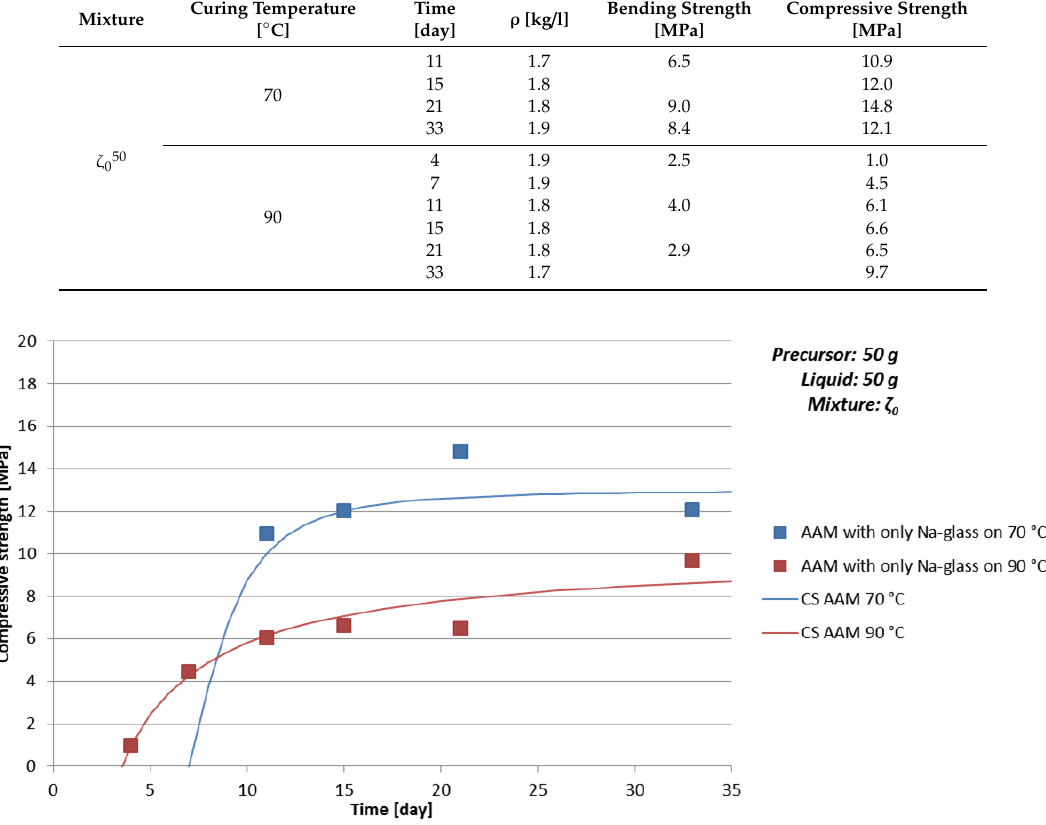
Figure 4. Time dependence of compressive strength of AAM prepared with mixture ζ 0 , cured on 70 ◦ C (blue) for seven days and cured on 90 ◦ C (red) for one day. Lines represent approximation of the compressive strength time development behaviour CS ↑ (Equation